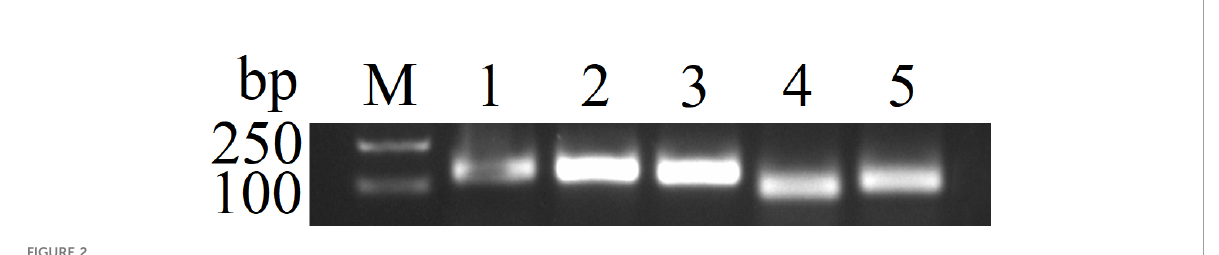
FIGURE 2 RAA primer screening. 1, RAA-F1/R1 (139bp); 2, RAA-F2/R2 (148bp); 3, RAA-F3/R3 (138bp); 4, RAA-F4/R4 (98bp); 5. RAA-F5/R5 (108bp). M: DNA Marker (100~2000 bp).